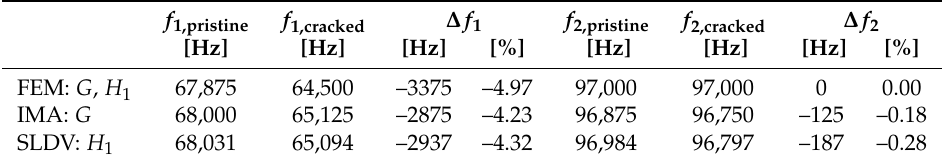
Figure 10. Comparison of numerically calculated conductance spectra for growing cracks at location ( a ) β in = 90° and ( b ) β out = 145°. Detailed plot of frequency spectra around each resonance frequency. Relations between frequency shifts ∆ f 1 and ∆ f 2 is based on absolute values. Table 3. Chosen resonances f 1 and f 2 of pristine and cracked state ( a in = 2mm, β in = 90°) from simulation and experiments to identify the crack